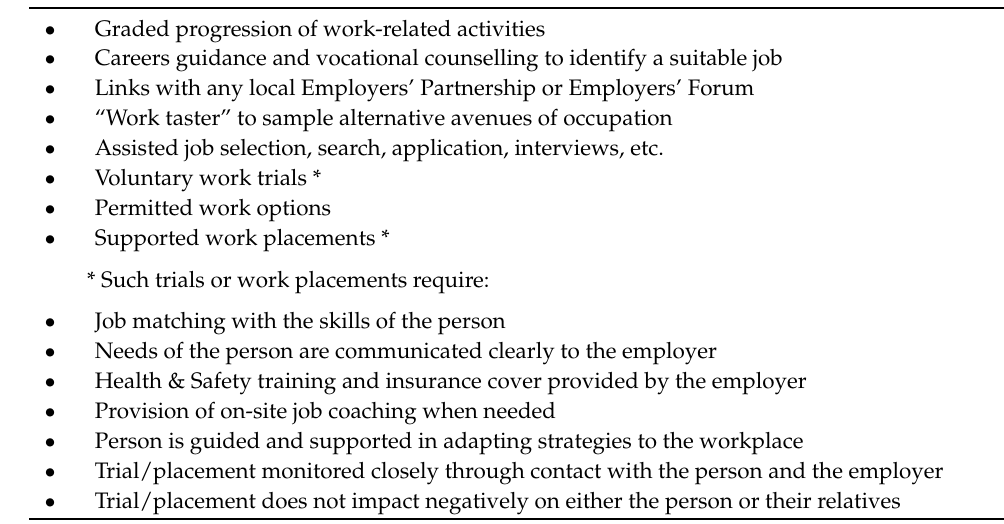
Table 4. Additional components to finding alternative or new work (from